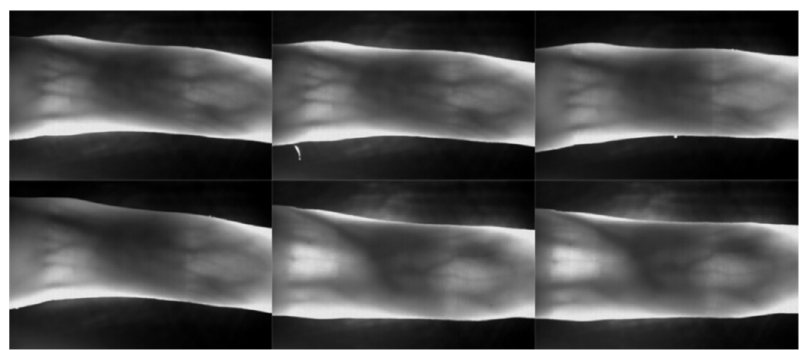
Figure 4. The sample images of SDUMLA-HMT Finger Vein Dataset. University of Twente Finger Vascular Pattern (UTFVP) dataset is the second dataset used for experimental evaluation. The dataset was collected from 60 individuals with 73% male, 87% right-handed, and 82% aged 19–30 at Twente University [17]. The finger vein images were captured with a local custom device. Each individual provides the index, middle, and ring finger of both hands, and each finger is sampled four times. In total, there are 1440 (60 individuals × 3 fingers × 2 hands × 4 samples) images in the dataset. Each of them is in a “png” format with 672 × 380 pixels in size. The samples of finger vein images from UTFVP can be seen in Figure 5.